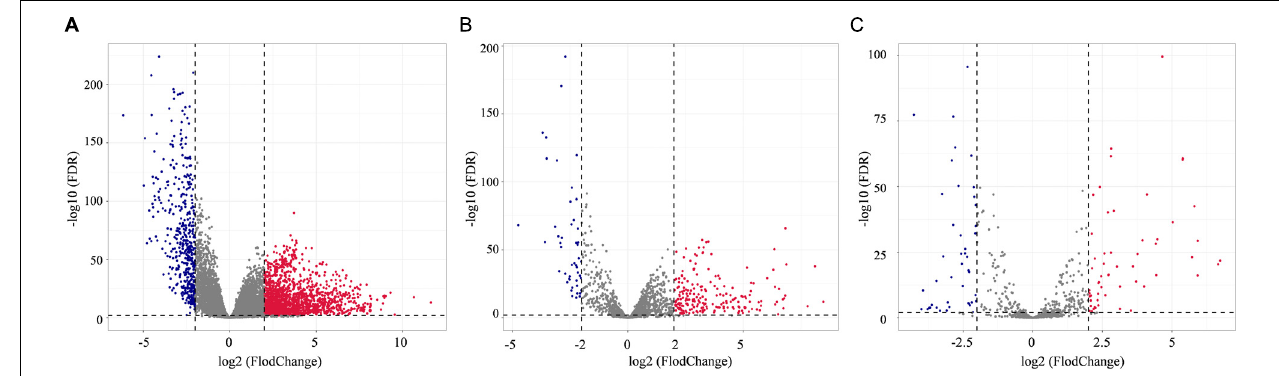
FIGURE 1 | Distribution of differentially expressed genes in lung adenocarcinoma (LUAD) (| log2FoldChange| > 2.0 and adjusted p value < 0.01) between 533 tumor tissues and 59 normal tissues. The volcano plots described 2378 DEmRNAs (A) , 357 DElncRNAs (B) , and 101 DEmiRNAs (C) . Red stands for up-regulations, blue stands for down-regulations, and gray stands for normal expression in volcanoes. Each point represents a